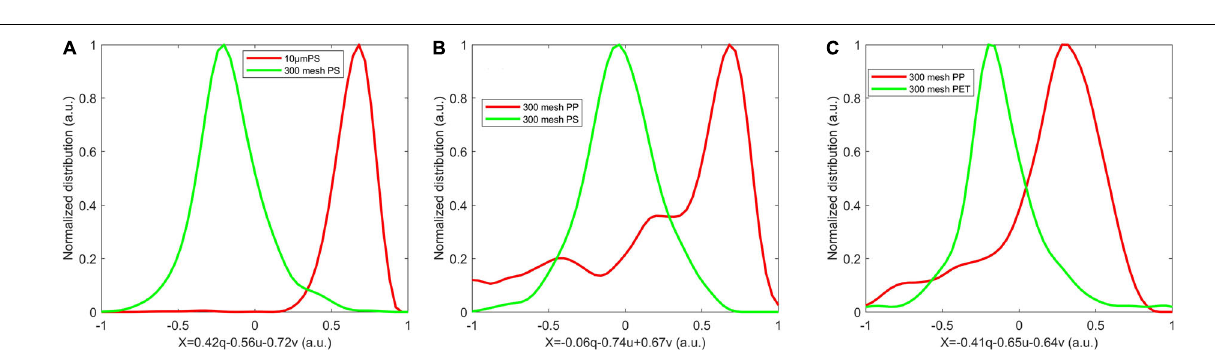
FIGURE 4 | Normalized distributions of different MP. (A) 10-micron spherical polystyrene (PS) and 300-mesh PS. (B) 300-mesh Prymnesium Parvum (PP) and 300-mesh PS. (C) 300-mesh PP and 300-mesh Polyethylene Eerephthalate